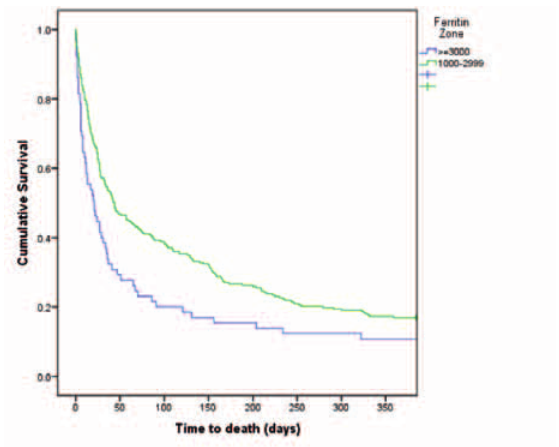
Figure 2. Freedom from death through 1